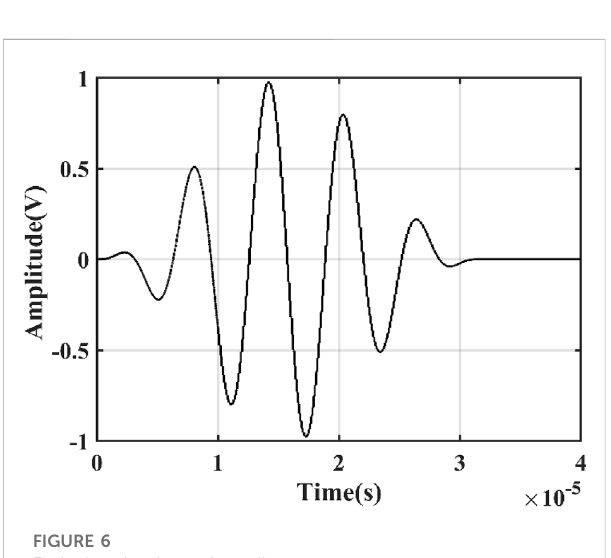
FIGURE 6 Excitation signal waveform diagram.